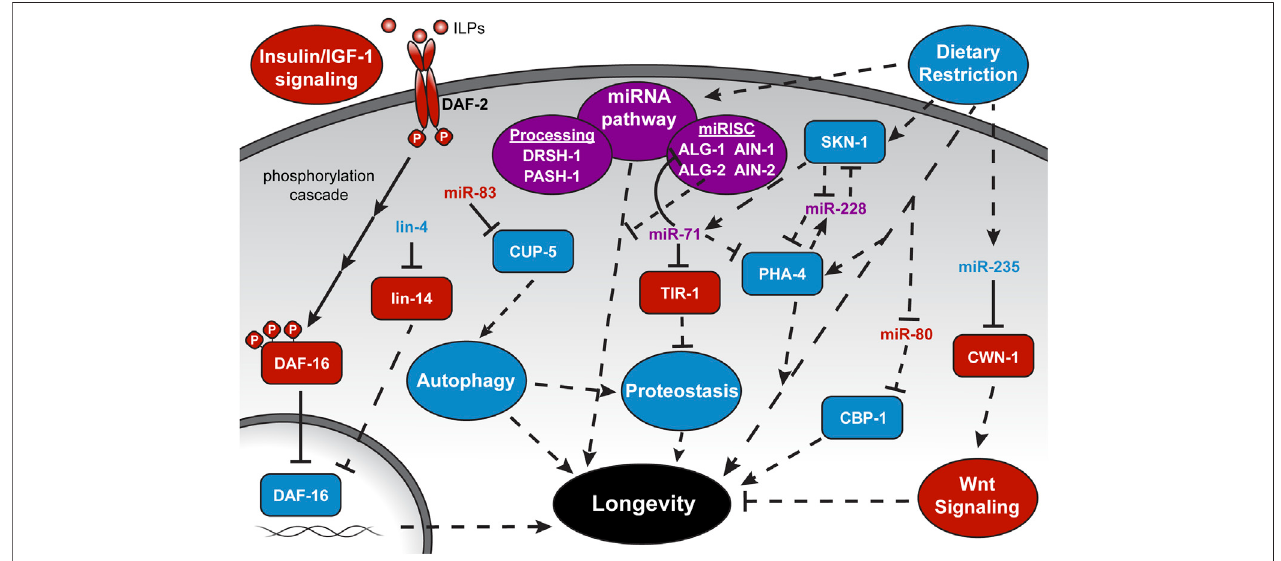
FIGURE2| MicroRNAregulationoflongevity-associatedpathways.DepictedisthecomplexinterplayamongmiRNAs,targets,andlongevitypathwayshighlighted in this review. More comprehensive schematics and discussion of individual pathways can be found in the recommended reviews in the introduction. ILPs, Insulin-like Peptides, and full gene names are provided at their fi rst mention in the text. Solid lines represent direct interactions. Dashed lines represent indirect or unknown interactions. Pathway names are within ovals, proteins are within rectangles, and miRNAs stand alone. A pathway or factor with a blue background or text color is considered “ lifespan-promoting, ” while red represents “ lifespan-antagonizing, ” and purple is ambiguous within the context depicted.